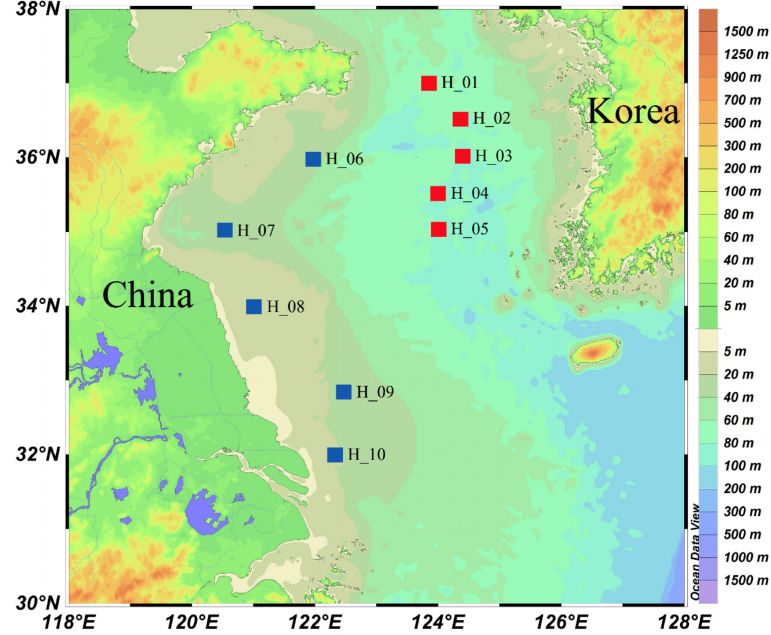
Figure 1. Location of sampling sites in the South Yellow